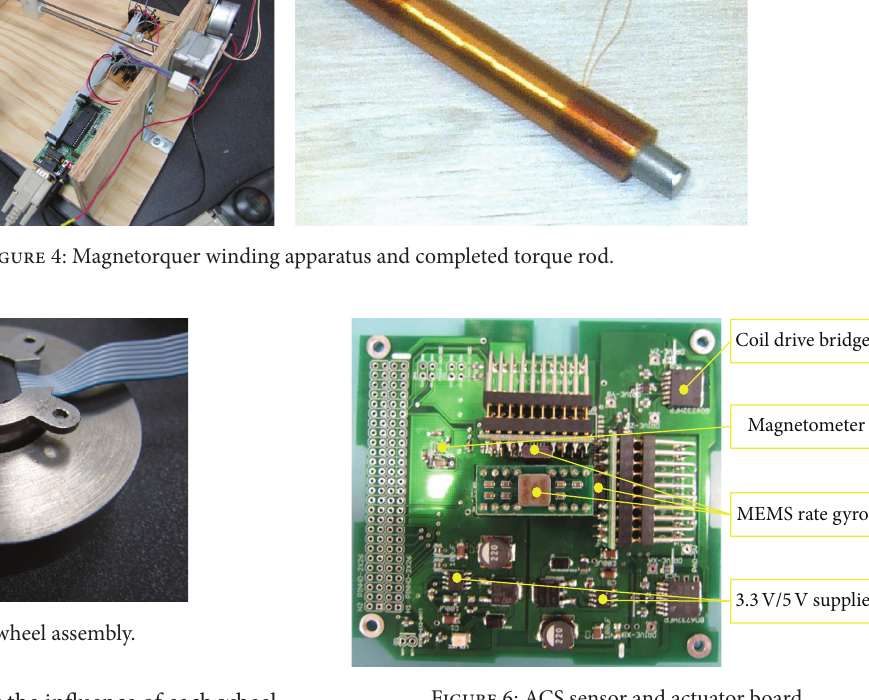
Figure 6: ACS sensor and actuator